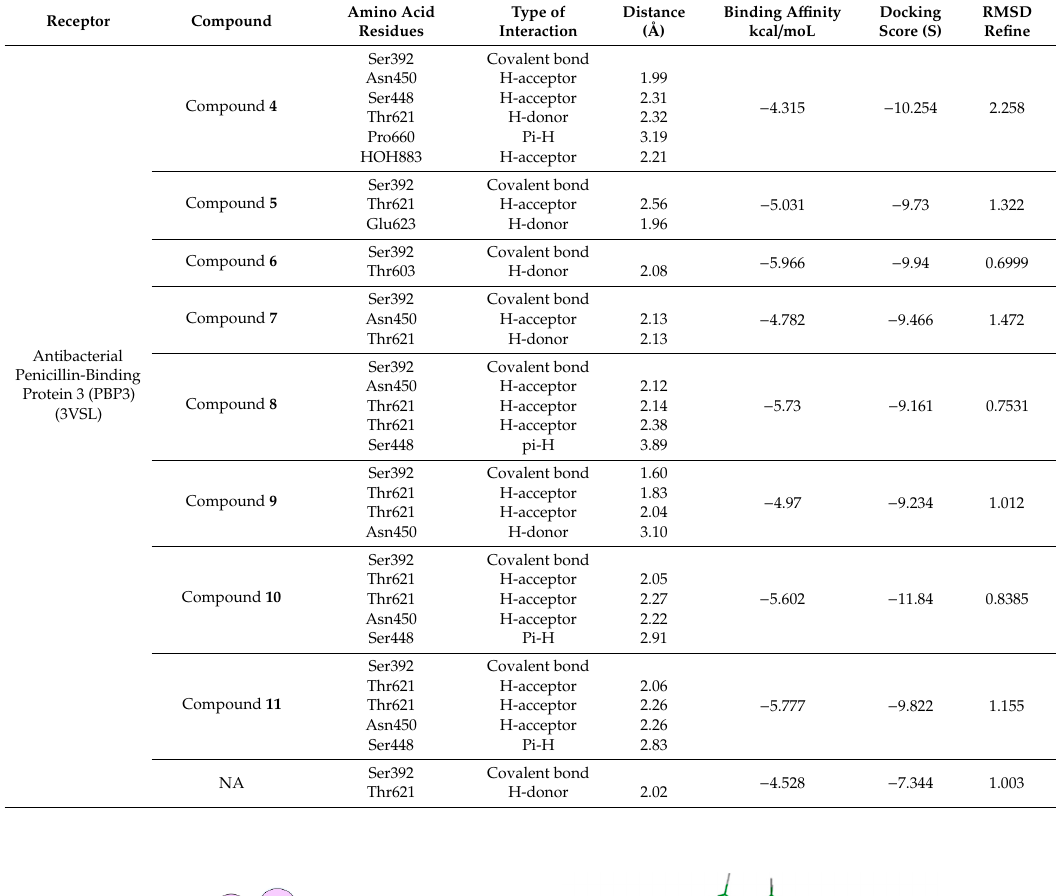
Table 4. Predicted covalent-binding-free energies ( ∆ Gbind) for ligands 4 – 11 .